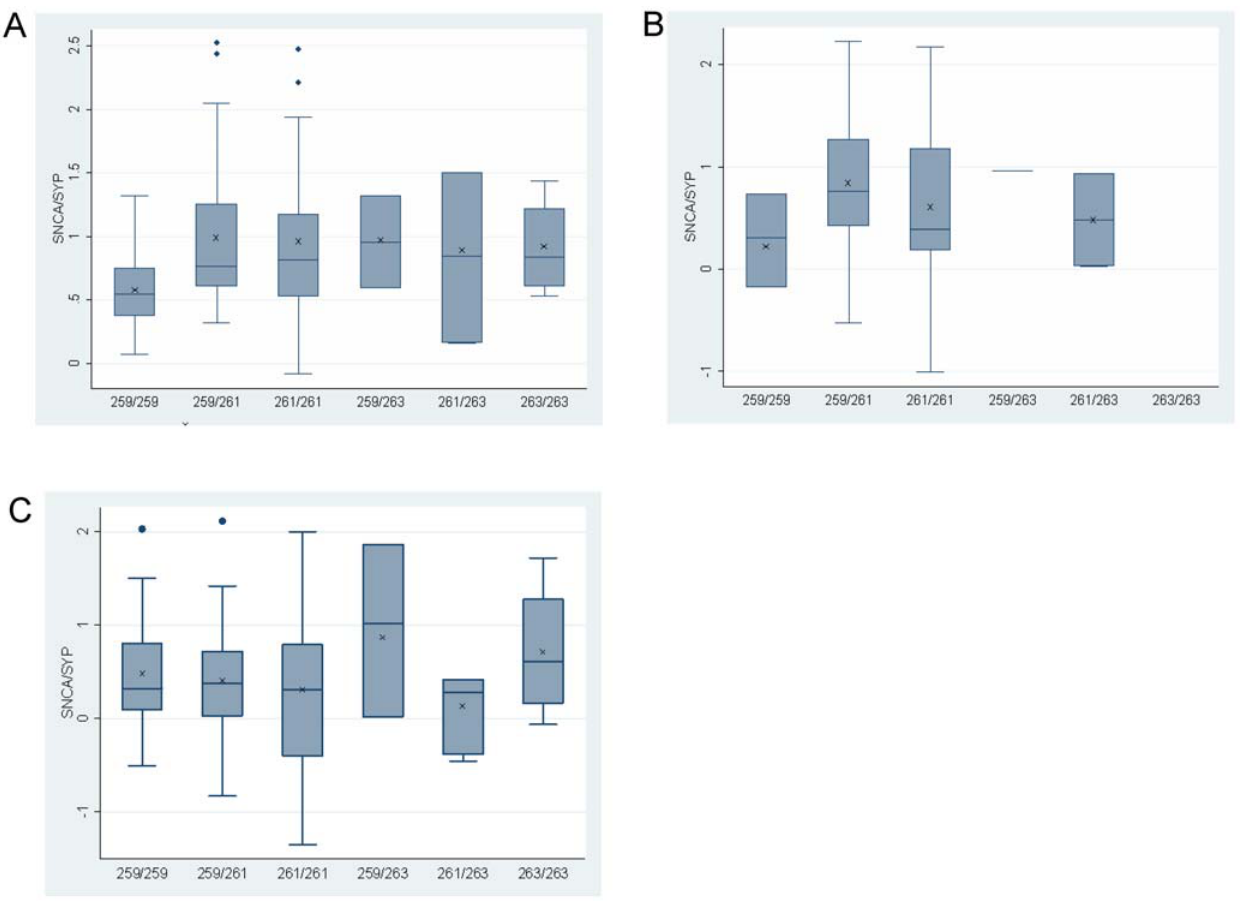
Figure 3. Effect of the SNCA -Rep1 promoter genotypes on human SNCA -mRNA expression levels in human brains. Individuals were genotyped for Rep1. Three brain regions were analyzed: temporal cortex ( A ), midbrain including SN ( B ) and frontal cortex ( C ). In each brain region fold levels of human SNCA -mRNA were assayed by real-time RT-PCR using TaqMan technology and calculated relative to human SYP -mRNA reference control using the 2 2 D Ct method. (A) Analysis of the temporal cortex showed that the protective genotype 259/259 correlates with lower SNCA -mRNA levels then the fiveother genotypes(P=0.02).The associationtrendwas confirmed ina subsetofsamplesusingalsothe GAPDH and ENO2 referencegenes(TableS2). (B) Inthe midbrain including SNthe 259/259 correlates, withlower SNCA -mRNA levels.(C) No correlationsofRep1genotypes with SNCA -mRNA levelswere detected in the frontal cortex. For each genotype the box plot represents the analysis performed using all brain samples available from the specific brain region, each of which was analyzed twice independently, each time in duplicate. The average values are presented in ‘X’. The box plot shows the median (horizontal line inside the box) and the 25 th and 75 th percentiles (horizontal borders of the box). The range between the 25th and 75th percentiles is the interquartile-range (IQR). The whiskers show the minimal and maximal values inside the main data body. doi:10.1371/journal.pone.0007480.g003 of SNCA mRNA than the GA and the GG genotypes (n= 38, 10), (n= 12, 16) correlate with higher SNCA mRNA levels than the risk amounting to a nearly 40% increase (Figure 4A). In the substania genotype GG (n= 6) (Figure 4B). In the frontal cortex, on the nigra, the homozygous AA and the heterozygous GA genotypes contrary, no correlation was identified between SNCA mRNA Table 4. Summary of the genetic correlations between genetic variants at SNCA locus and SNCA-mRNA levels.